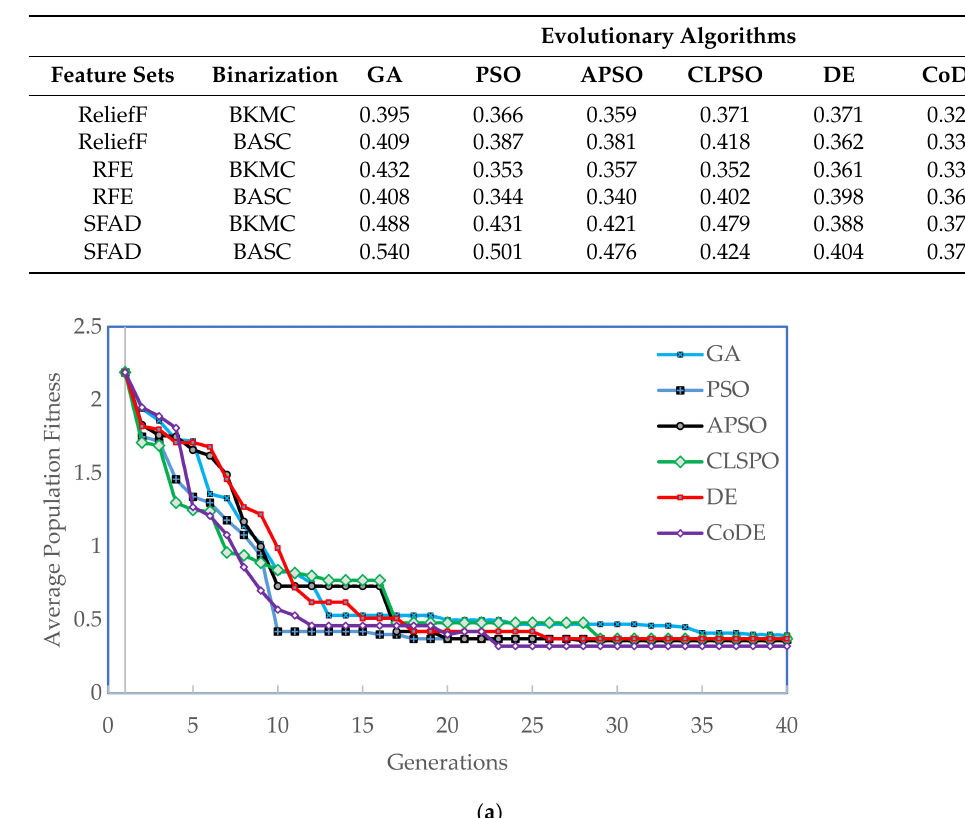
Table 5. Average population fitness (average surface roughness) in terminating generation.